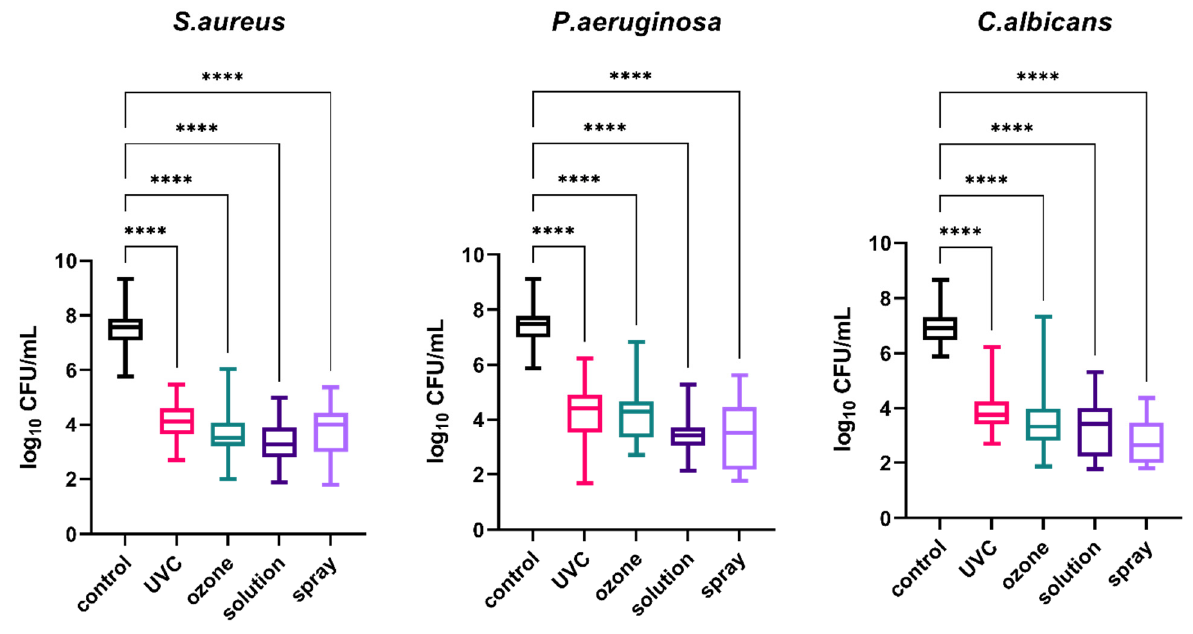
Figure 2. Effect of four methods (UVC, ozone, solution, and spray) used for the disinfection of all the studied materials (regardless of the type of material) contaminated with oral pathogens ( S. aureus , P. aeruginosa , and C. albicans ); the control material was contaminated but not disinfected; **** p < 0.0001 for all comparisons between the study (disinfected) groups and the control (non-disinfected) group. S. aureus—Staphylococcus aureus ; P. aeruginosa—Pseudomonas aeruginosa ; C. albicans—Candida albicans ; UVC—ultraviolet C.